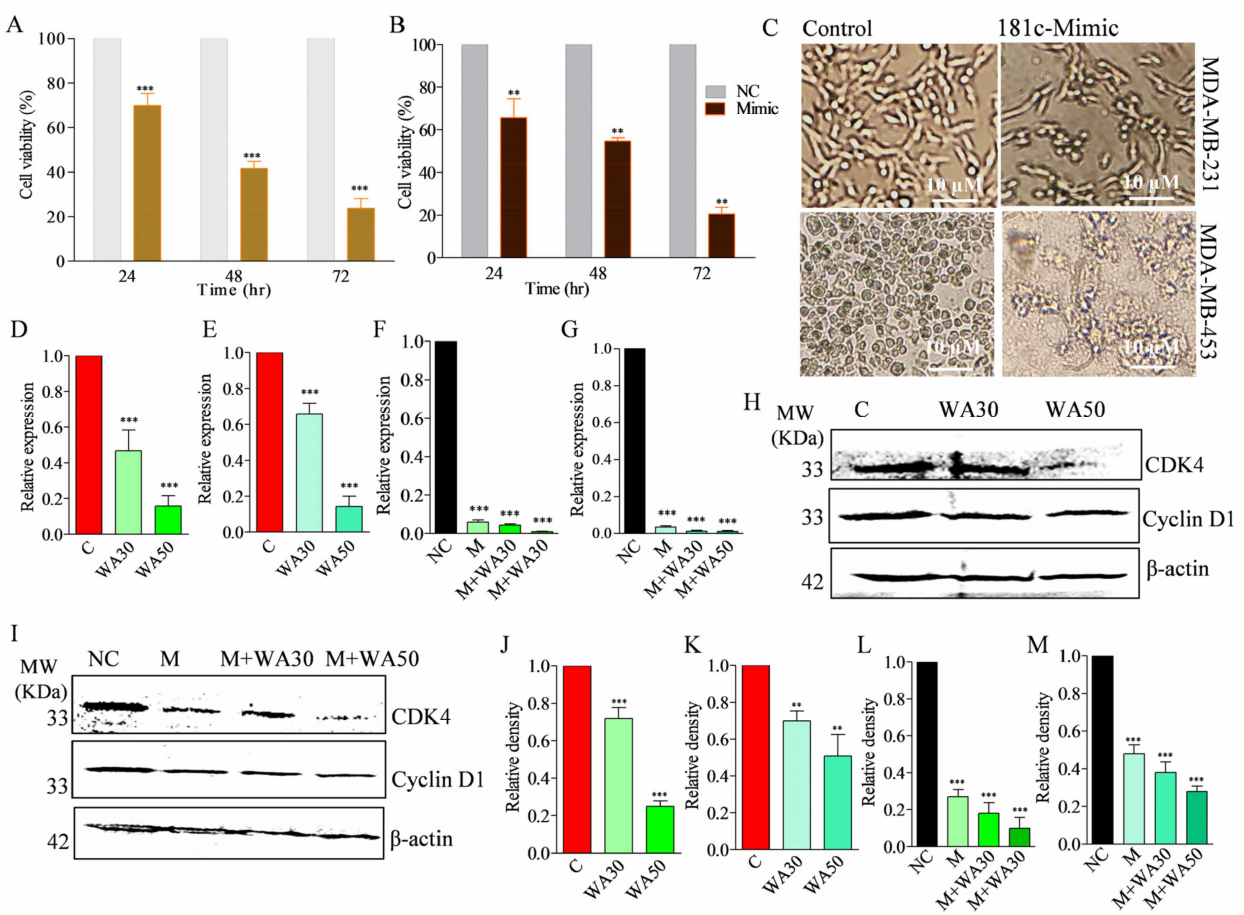
Figure 4. The effect of miR-181c-5p forced expression on cell viability and morphology, and the effect of Withaferin A and co-treatment (mimic and Withaferin) on cell-cycle marker proteins in triple-negative breast cancer cells. ( A ) Effect of miR-181c-5p forced expression on MDA-MB-231 cell viability in 24, 48, and 72 h exposure at 60 nm concentrations. ( B ) Effect of miR-181c-5p forced expression on MDA-MB-453 cell viability in 24, 48, and 72 h exposure at 60 nm concentrations. ( C ) Effect of miR-181c-5p forced expression on MDA-MB-231 and MDA-MB-453 cell morphology in 24 h exposure at 60 nm concentration. The mRNA gene expression of ( D ) CDK4 and ( E ) CCND1